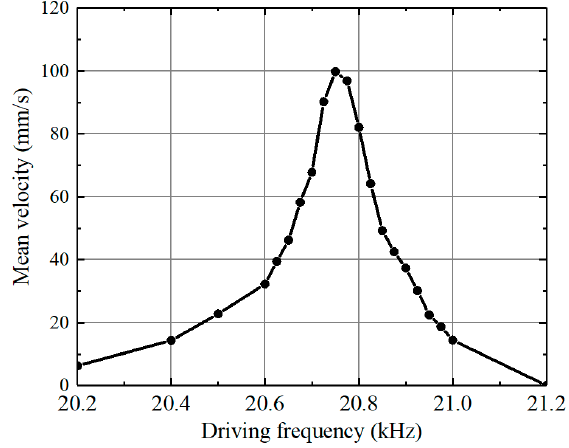
Figure 10. Frequency sensitivity characteristic of the actuator prototype.